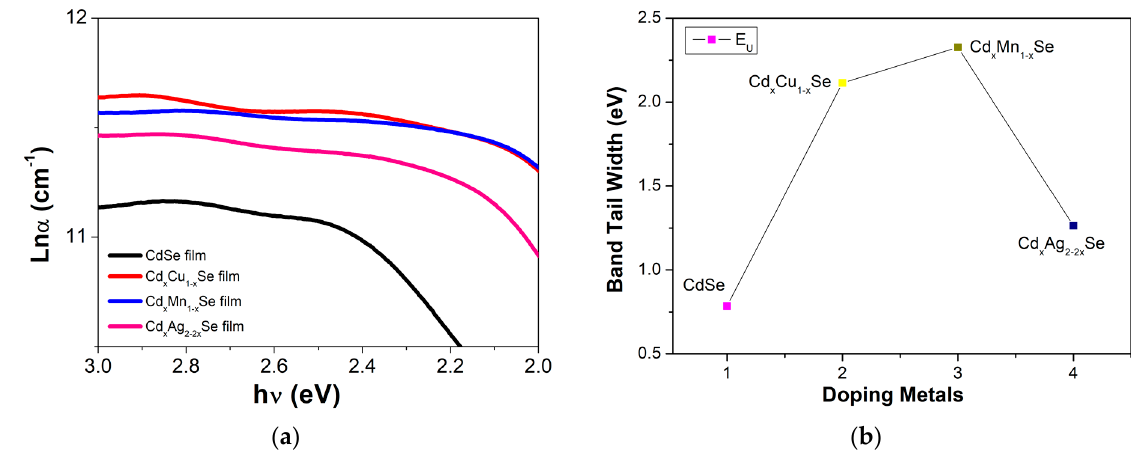
Figure 4. The dependence of ( a ) the ln( α ) of the films and ( b ) the Band tail energy on the compositional TiO 2 /CdS/CdxCu 1 − x Se, and TiO 2 /CdS/Cd x Mn 1 − x Se and TiO 2 /CdS/Cd x Ag 2 − 2x Se thin films.